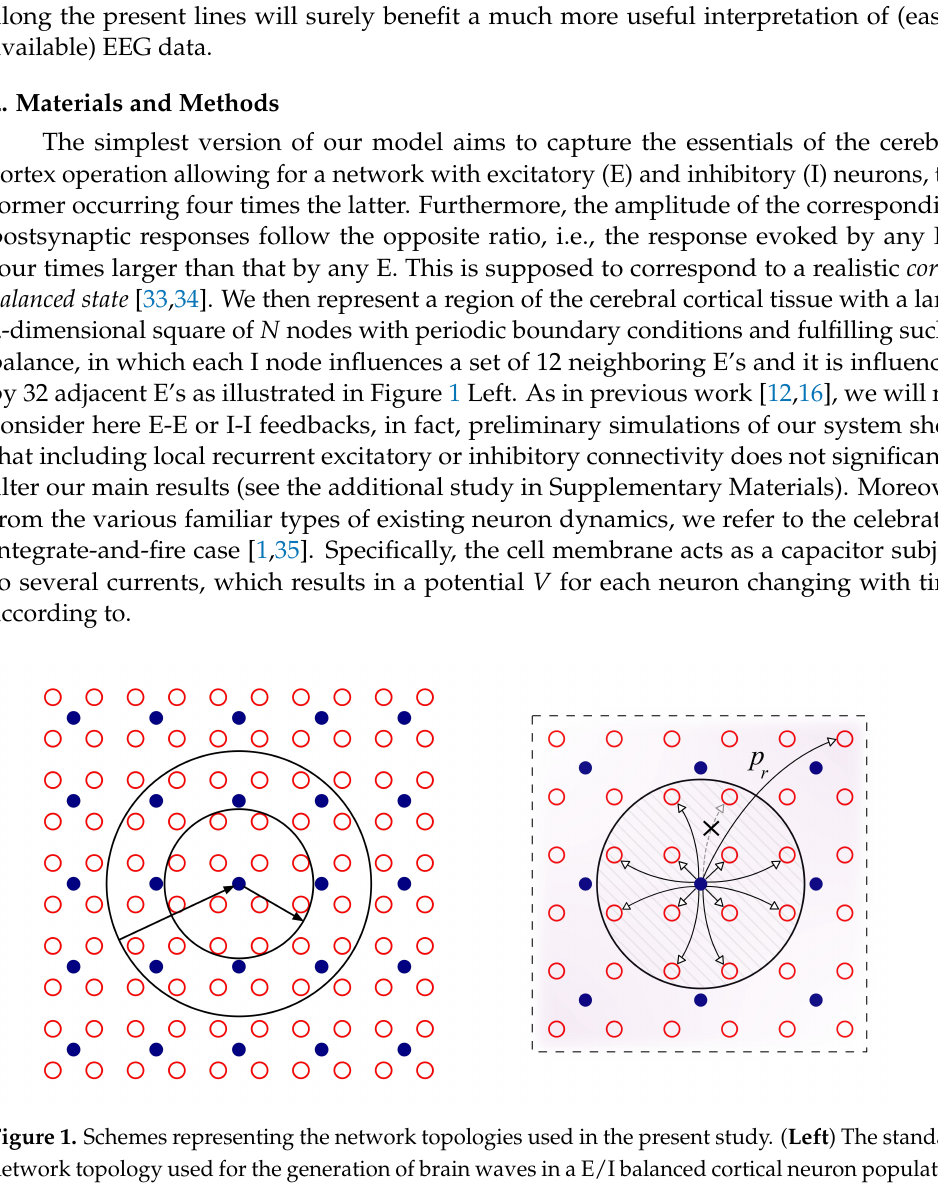
Here, as in previous works [12,16], the time constant τ is set equal to τ 1 ( τ 2 ) when the membrane cell voltage is above (below) a certain resting potential, which we set